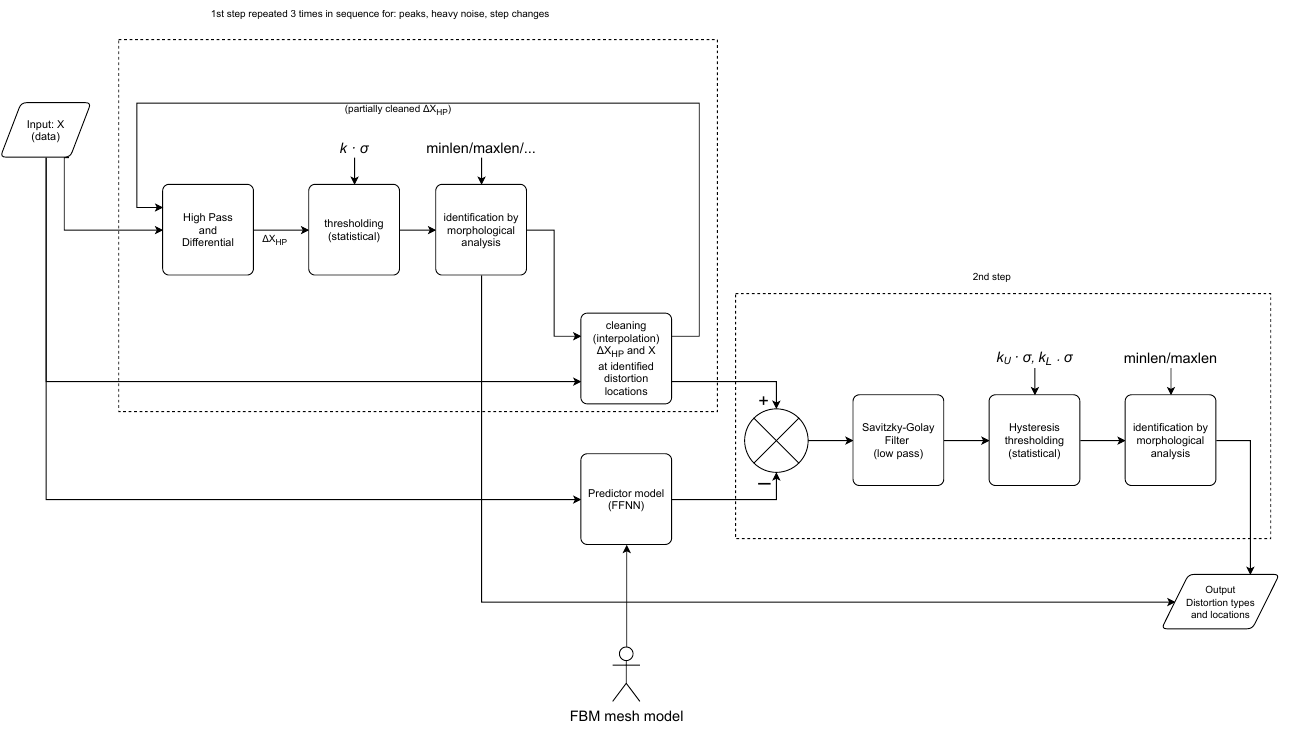
Figure 4. Conceptual schematic of the proposed